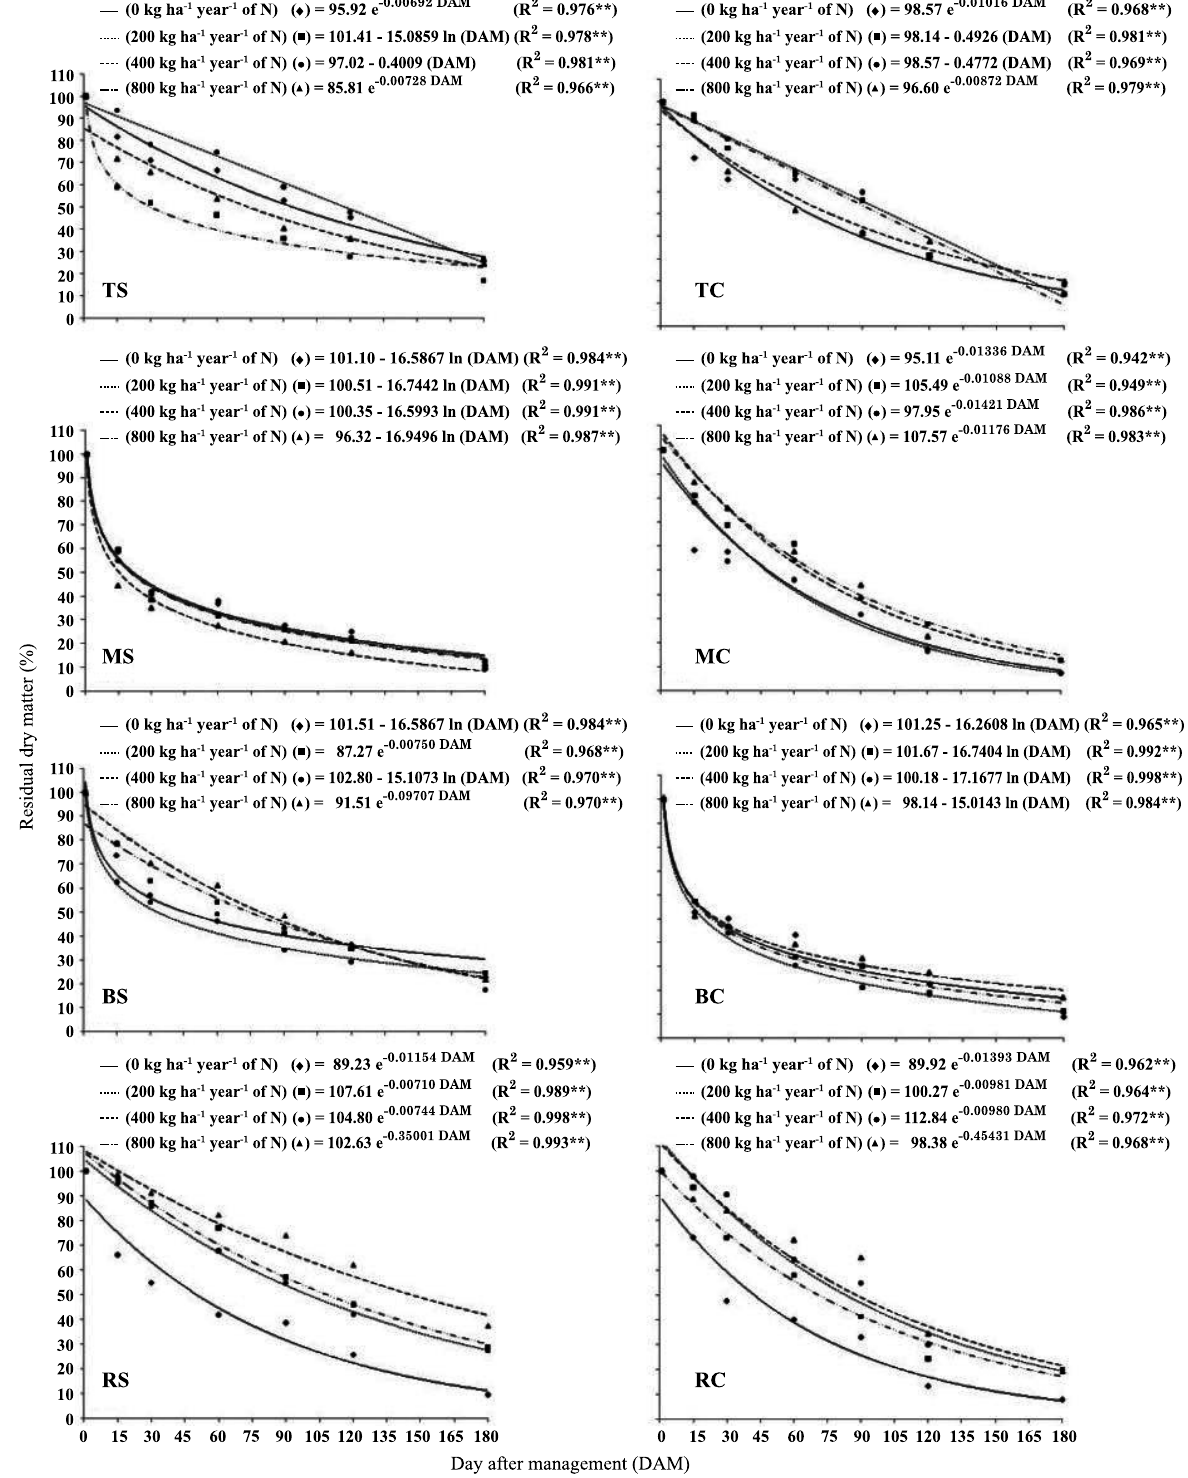
Figure 4. Straw decomposition percentage (residual dry matter) of Panicum maximum cv. Tanzânia, P. maximum cv. Mombaça, Brachiaria brizantha cv. Marandu and B ruziziensis grown intercropped with maize, N-fertilized (applied at four cuts) and chopped after the last cut in winter/spring. TS, MS, BS and RS: Panicum maximum cv. Tanzânia, P. maximum cv. Mombaça, Brachiaria brizantha cv. Marandu and B. ruziziensis sown together with maize, respectively; TC, MC, BC and RC: Panicum maximum cv. Tanzânia, P. maximum cv. Mombaça, Brachiaria brizantha cv. Marandu and B. ruziziensis sown at the time of N side dressing of maize, respectively. **: (p <